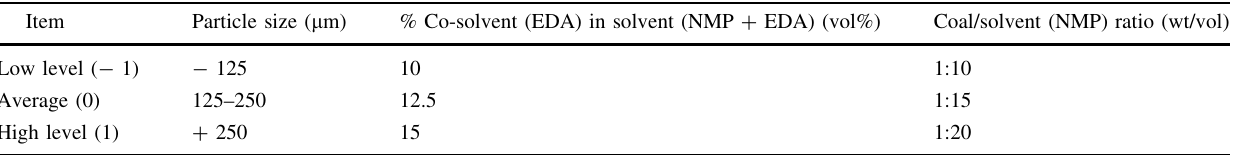
Table 5 Three levels for the factorial design (for RSM methodology—further optimization of extraction